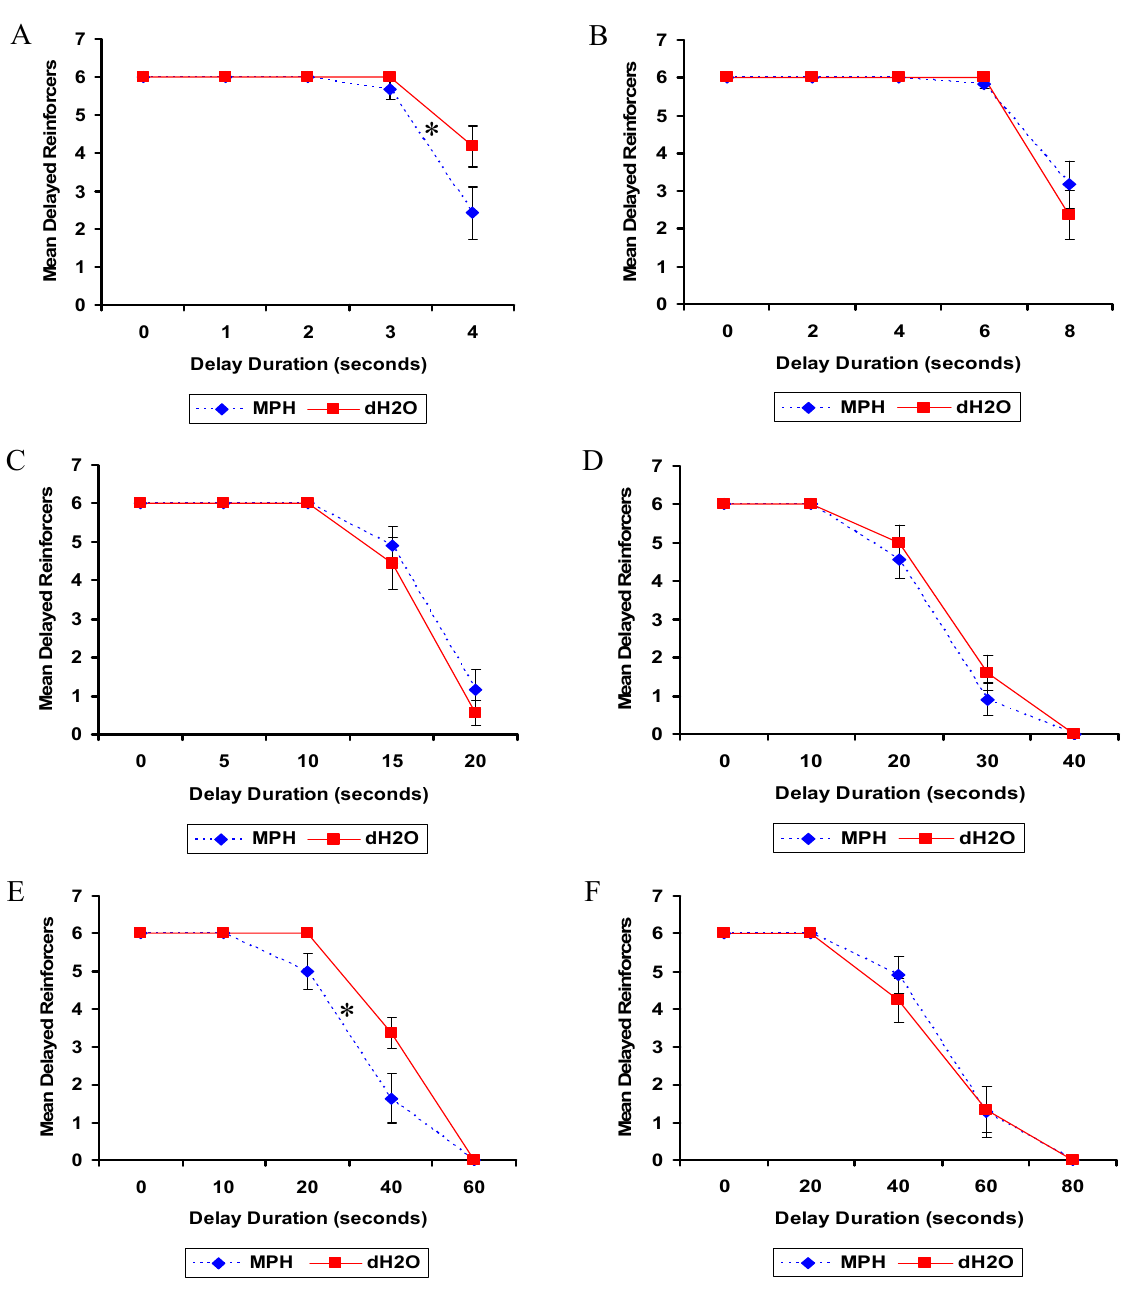
Figure 4. WKY rats: Mean (±SEM) delayed reinforcers attained in Test 1 to 7 ( A – G ) of the Delayed Reinforcement Task by rats previously exposed to 4 weeks of methylphenidate (MPH, 2 × 2 mg/kg/day) or distilled water (dH O) treatment. One test was conducted each 2 day over a period of 7 days (15–21 days post-treatment). * Significant difference between treatments, p <